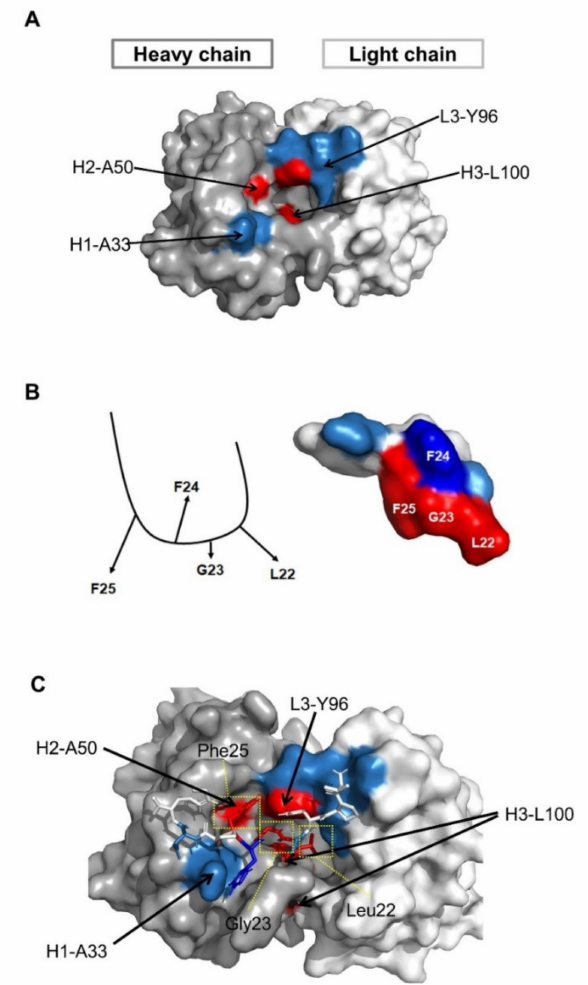
Figure 5. Structural analysis of the epitope–paratope interaction by molecular modeling. ( A ) Struc- tural model of the VH (dark gray) and VL (light gray) of 1A8 with H2-A50. The residues that are essential for antigen binding are shown in red, and those that are less important or not involved in antigen binding are shown in blue. ( B ) Schematic diagram of the structure of the preS1 peptide. The three residues (Leu22, Gly23, and Phe25), shown in red, were identified as the fine epitope of 1A8. ( C ) Docking of the antigen and antibody models using the ClusPro